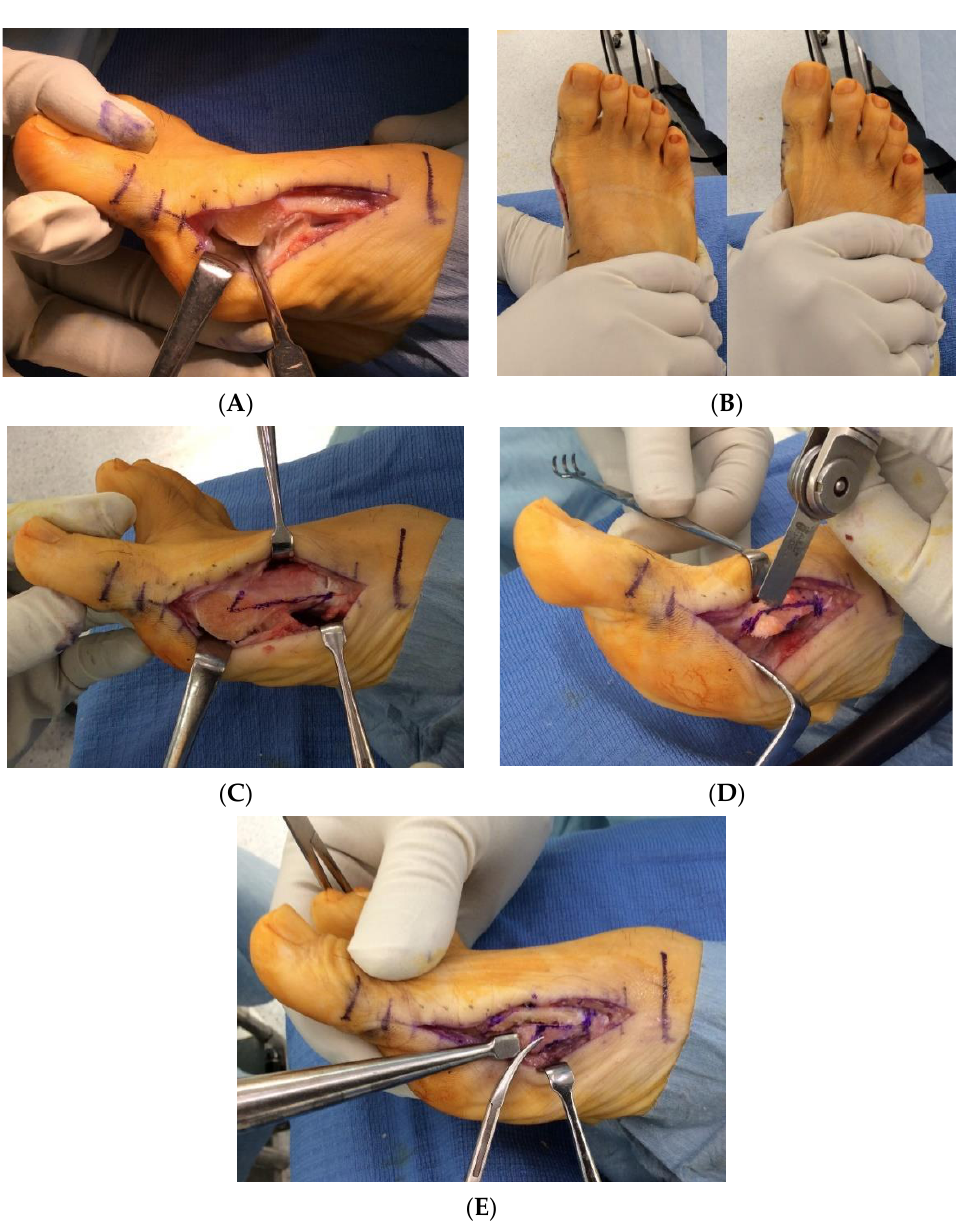
Figure 1. Intraoperative pictures showing the key steps in our procedure for correcting hallux valgus in patients with rheumatoid arthritis. ( A ) Lateral soft tissue release was performed intra-articularly through a single long medial longitudinal skin incision and a capsular incision at the first metatarsophalangeal joint. Blunt dissection of the lateral metatarsosesamoid suspensory ligament was performed using elevatorium followed by sharp dissection using dissection scissors. ( B ) Lateral soft tissue release was performed in a stepwise fashion until the manual correction of the intermetatarsal angle between the first and second metatarsals spontaneously corrected the hallux valgus deformity. It involved the following three steps: (1) dissection of the lateral metatarsosesamoid suspensory ligament, (2) lateral capsulotomy at the joint level, and (3) tenotomy of the adductor tendon insertion into the proximal phalanx. ( C ) Transverse part of scarf osteotomy was performed connecting two apexes; one was located at the center of the metatarsal head and the other at the plantar one-third of the metatarsal 10 mm distal to the first tarsometatarsal joint. ( D ) After the lateral translation of the distal fragment and internal fixations of the proximal and distal fragments with two cannulated headless screws, the prominent medial bone of the proximal fragment was excised in the shape of a wedge. ( E ) Excised fragment was impacted intramedullary in the plantar and proximal regions with the wedge turned backward and upside